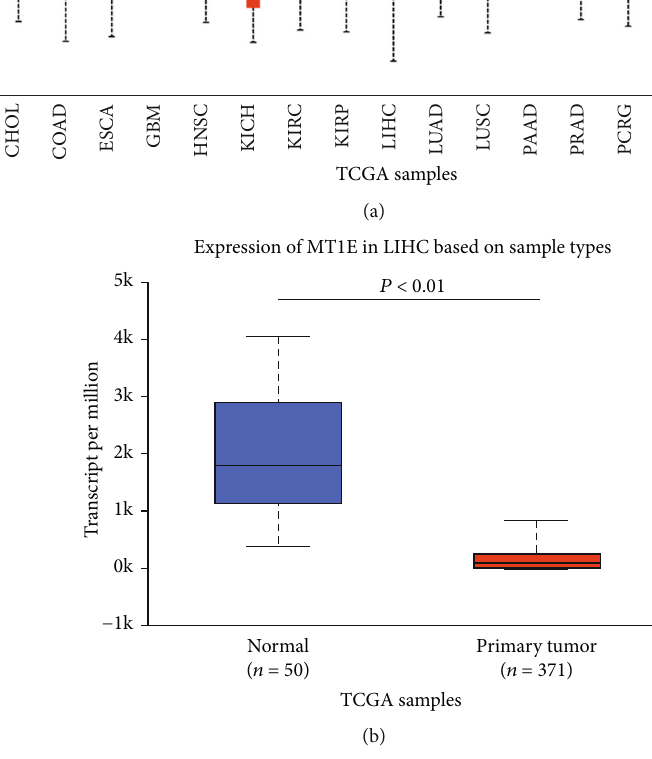
Expression of MT1E in LIHC based on sample